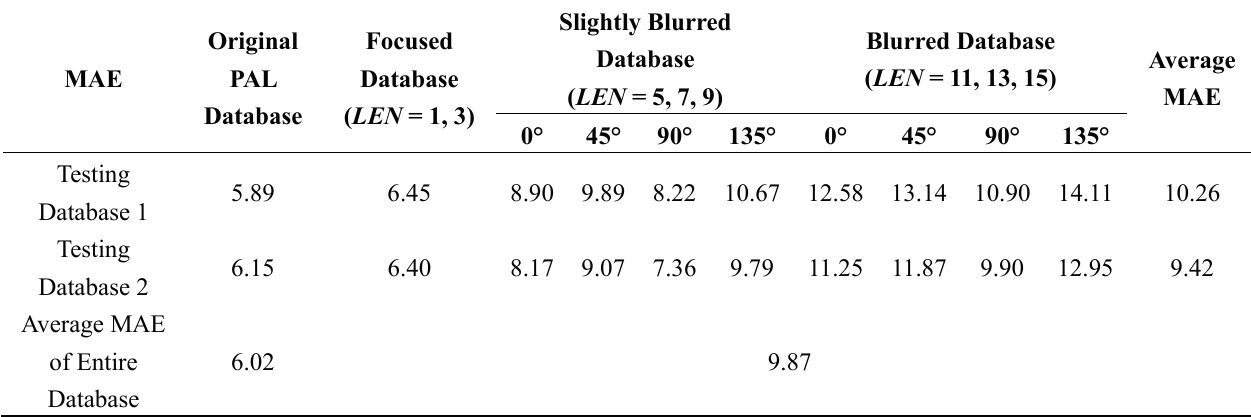
Table 6. Estimation results of motion blur database without our proposed age estimation